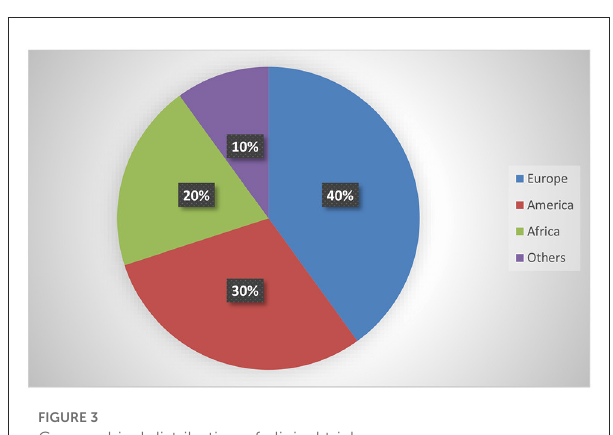
FIGURE3 Geographical distribution of clinical trials.